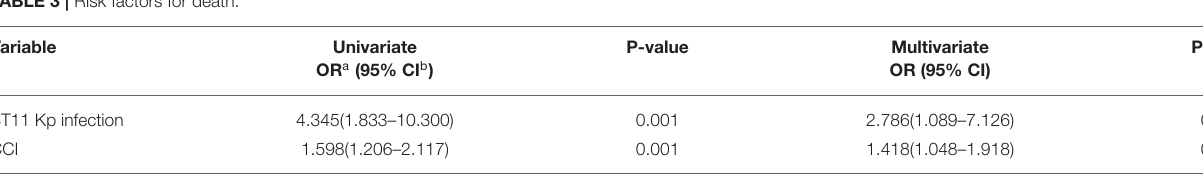
TABLE 3 | Risk factors for